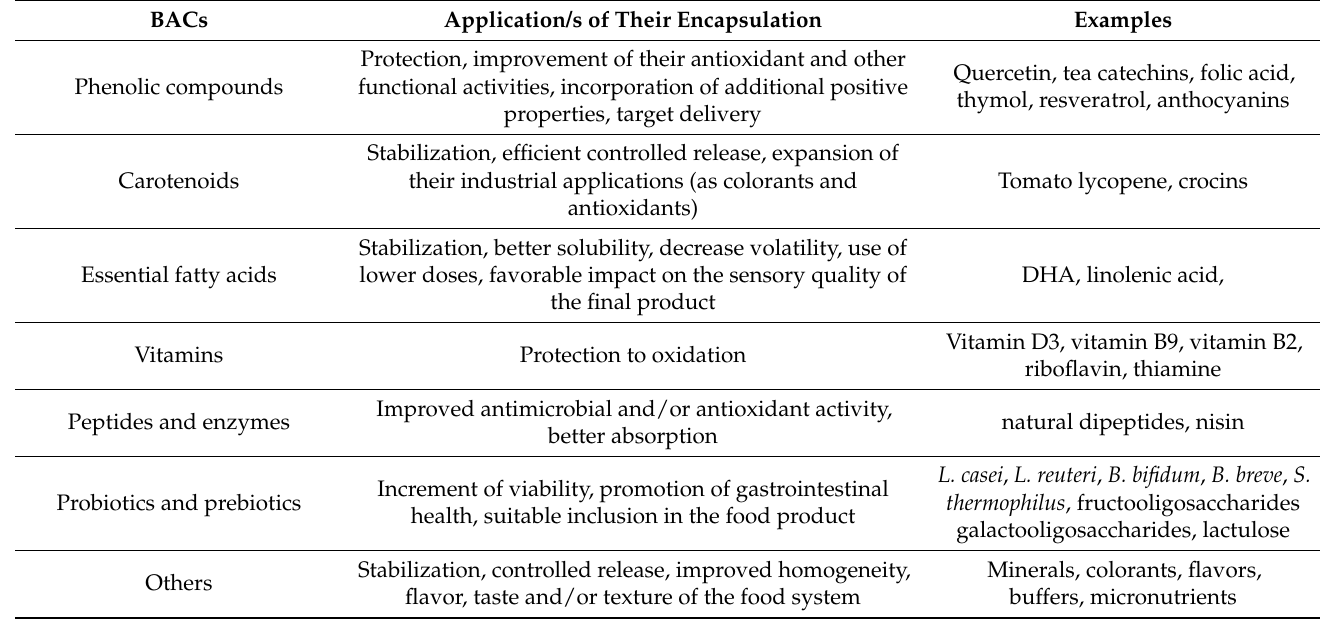
Table 1. Summary of habitual food BACs (core substances) that are susceptible to be nanoencapsulated. BACs